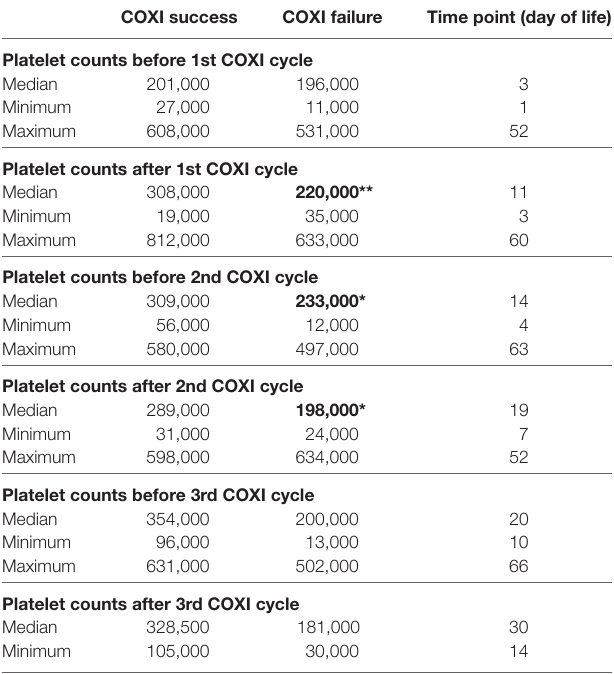
TaBle 2 | Platelet numbers in very low birth weight infants treated for hemodynamically significant PDA before and after each course of cyclooxygenase